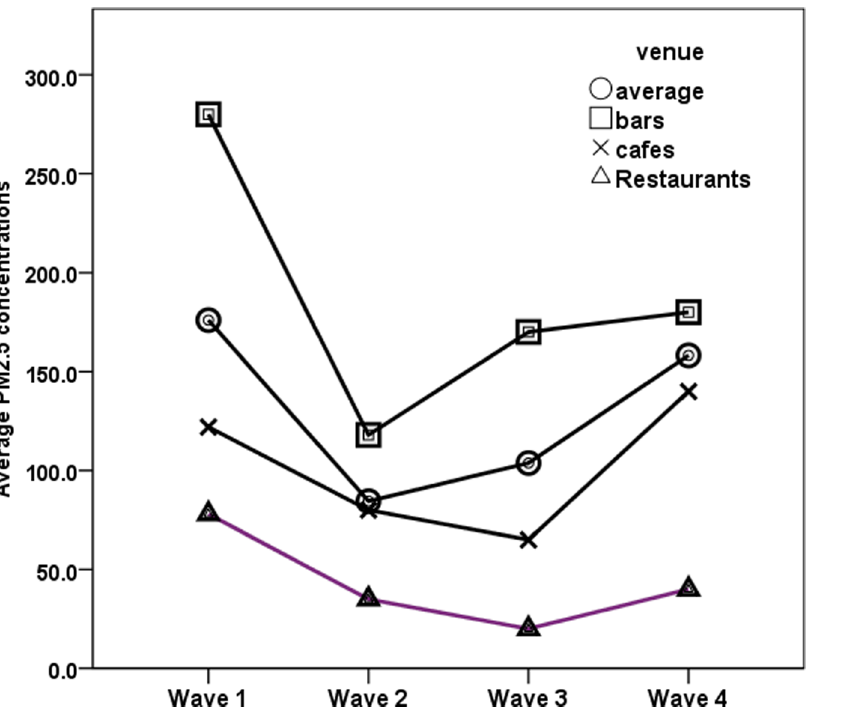
Figure 1. Temporal trends in mean PM 2.5 concentrations within venues of the Hellenic Air Monitoring Study, Greece, 2010–2011. doi:10.1371/journal.pone.0072945.g001 PLOS ONE |